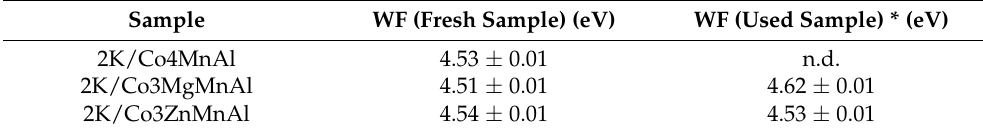
Table 8. Work function values.